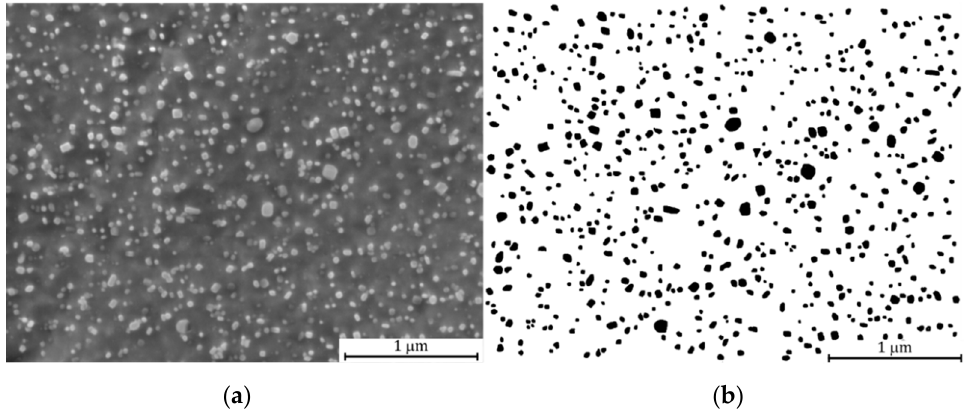
Figure 2. ( a ) The secondary electron SEM image surface of the specimen aged at 1400 °C for 30 min after final etching by the Vilella-Bain etchant; ( b ) particle analysis corresponding to left micrograph.